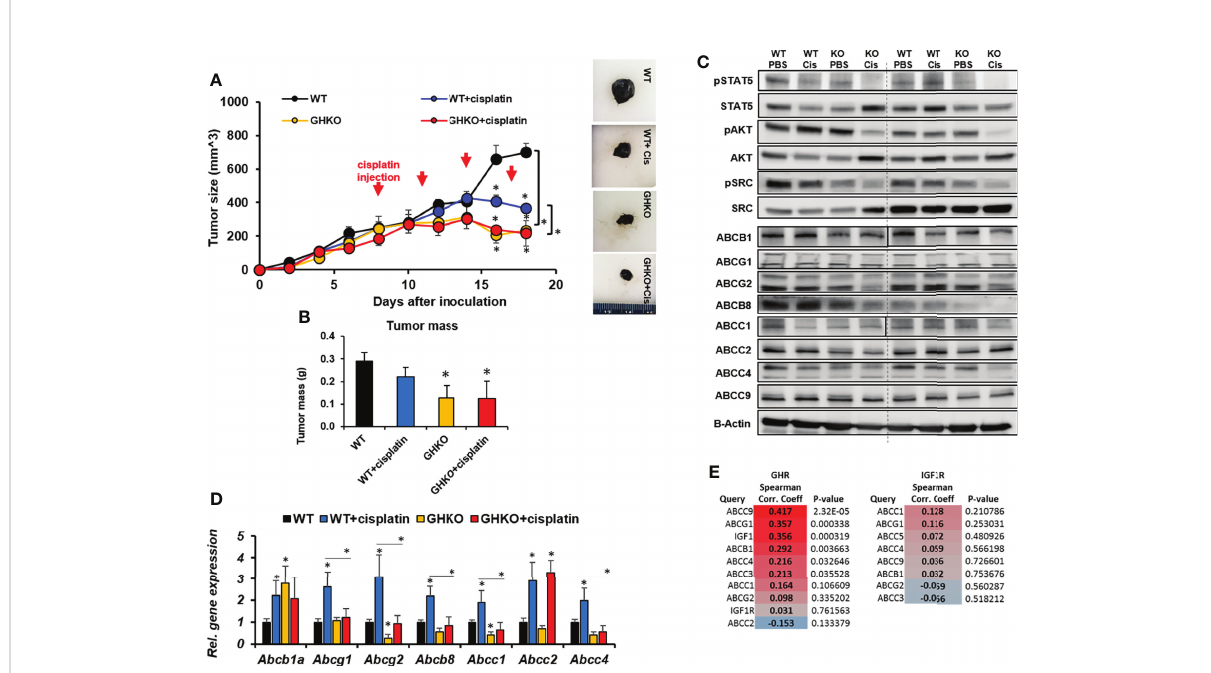
FIGURE 3 Effect of absence of GH on response of syngeneic mouse melanoma tumors to cisplatin treatment in vivo . (A) Mouse Fluc-B16-F10 cells were grafted intradermally on the right fl ank of syngeneic C57BL6/J wild-type (WT) and GH knockout (GHKO) mice (n=6). The changes in tumor volume (Fluc-B16-F10 in WT and GHKO mice) from digital caliper measurement and representative tumors post-dissection (A) and tumor mass (B) corroborate suppressed tumor growth in GHKO mice but not improved tumoral response to cisplatin in the GHKO mice. Western-blot assessment of GH downstream signaling and ABC transporter protein levels (C) and qPCR analysis of ABC transporter RNA expression involved in multi-drug ef fl ux from the tumors in WT and GHKO mice (D) are shown. (*p < 0.05, mouse studies – repeated measure using SPSS; other assays - Students t test, n = 3). (E) Spearman correlation analysis for transcript levels of GHR and ABC transporter and IGF1R and ABC transporters in 471 human melanoma patients in the TCGA cohort (generated using